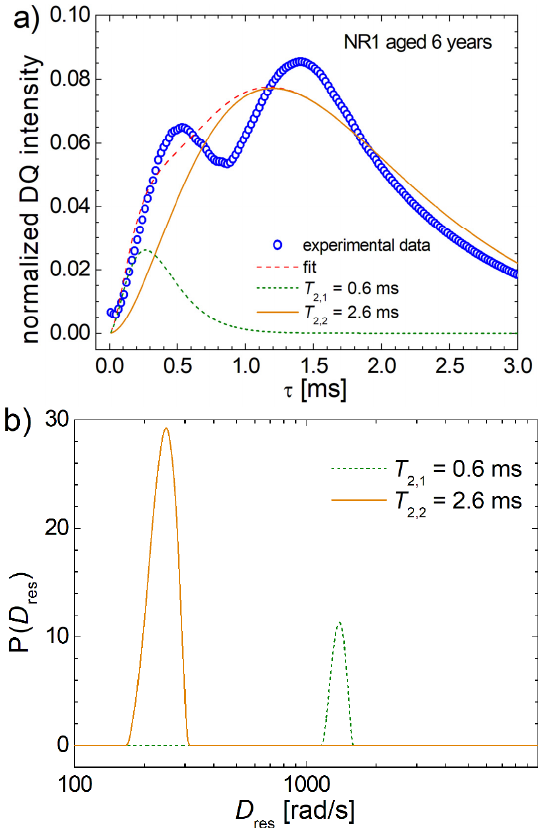
Figure 8. ( a ) The DQ build-up curve (open circle) measured for the NR1 sample naturally aged during 6 years, the fitting curve obtained after the Laplace-like inversion (dashed line) using a full mediation over average over dimensionless squared end-to-end vector, 𝑞⃗ (cid:2870) and azimuthal angle β (Equation (S11) from Supplementary Information), the DQ NMR signals corresponding to the small D res values (continuous orange line) and to the large D res values (dotted olive line); ( b ) the distributions of residual dipolar coupling constants resulted from the analysis of data presented in ( a ) by Laplace-like inversion using Equation (S11) with 𝑇 (cid:2870),(cid:2869)∗ = 0.6 ms and 𝑇 (cid:2870),(cid:2870)∗ = 2.6 ms obtained as the best fit of experimental data.